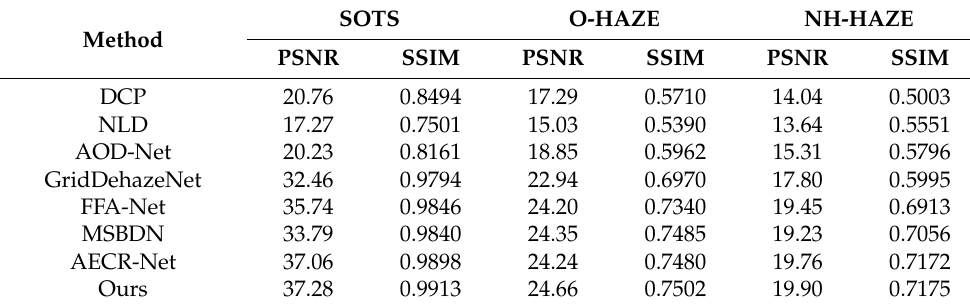
Table 1. Quantitative comparisons on both synthetic and real-world datasets.